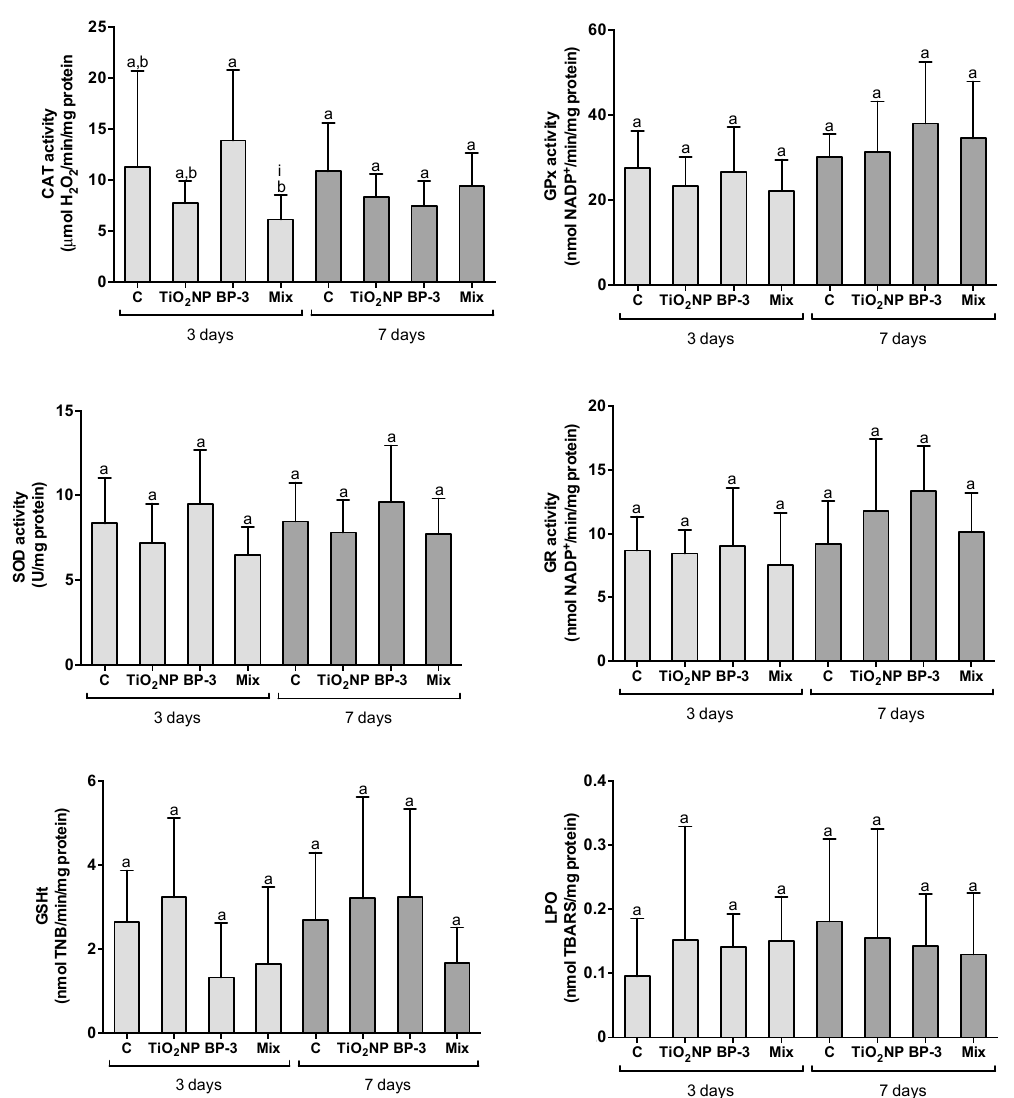
Figure 3. Oxidative stress responses in the kidney of S. maximus , 3 and 7 days after intraperitoneal injection of titanium dioxide nanoparticles (TiO 2 NPs; 3.0 µ g TiO 2 NP per g fish weight), oxybenzone (BP-3; 3.0 µ g BP-3 per g fish weight) or their mixture (Mix), as well as the respective control group (C). Different lower-case letters denote significant differences ( p < 0.05). Significant interaction between TiO 2 NPs and BP-3 is depicted by (i) ( p < 0.05). Columns correspond to mean and error bars represent the standard deviation.